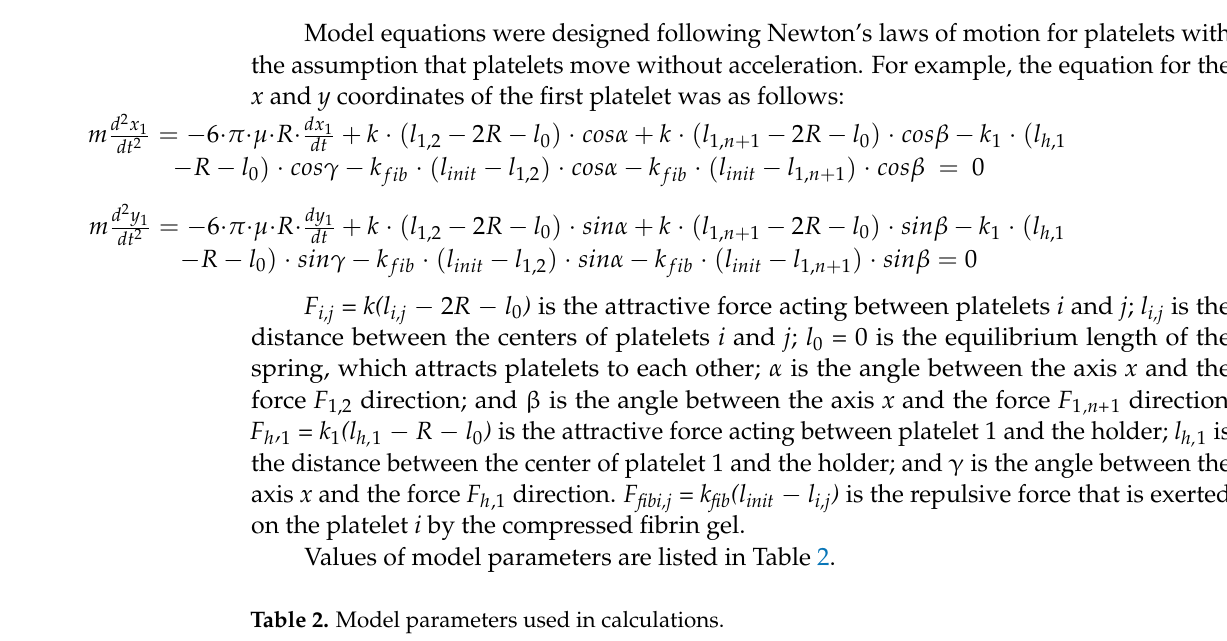
Table 2. Model parameters used in calculations. Model